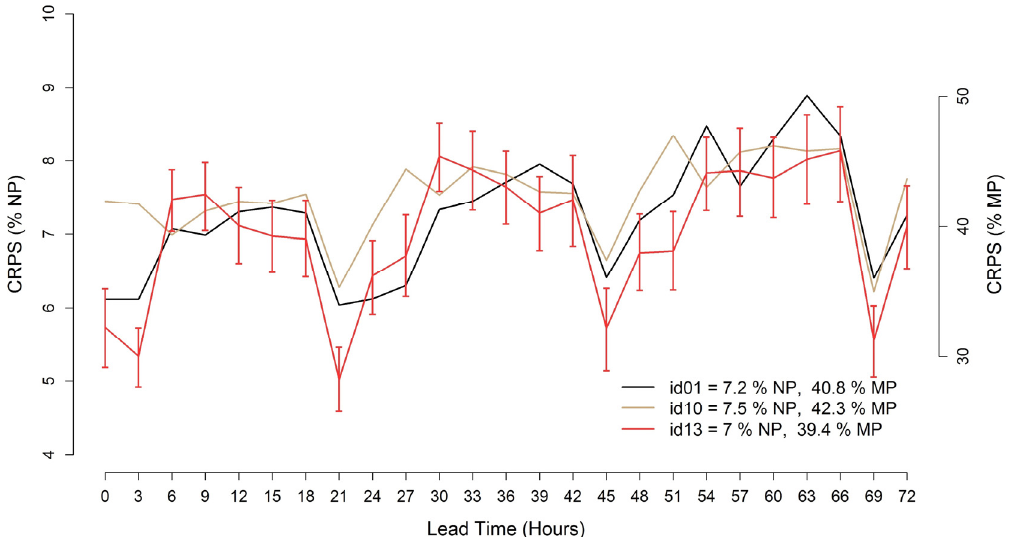
Figure 10. Error trends of the 0–72 h ahead probabilistic wind power forecasts starting at 12 UTC for the Abruzzo test case ( CRPS / NP % and CRPS / MP %). Statistical consistency is checked with the rank histograms reported in Figure